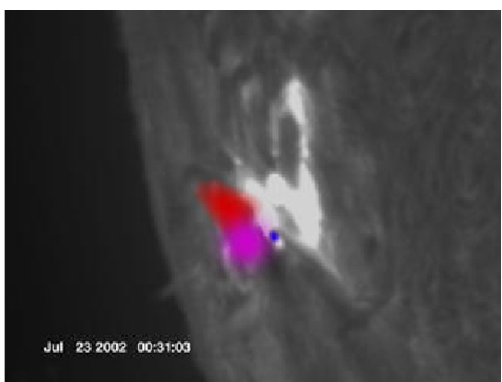
Fig. 1 Still from a movie: Soft X-rays ( red ), hard X-rays ( blue ) and gamma-rays ( purple ) observed by the RHESSI satellite are overlaid on an optical H α image. The movie starts in white light zooming into an active region. The color then changes to the H α line of hydrogen, emitted in the chromosphere. Its brightening indicates the start of the